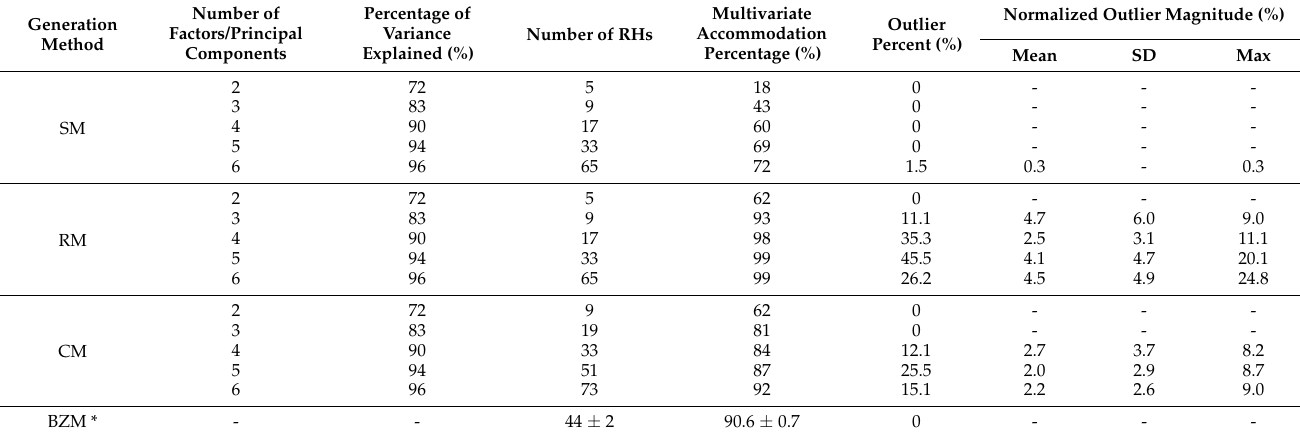
Table 2. Performance comparison of multivariate representative humanoid generation methods (SM, square method; RM, rectangular method; CM, circular method; BZM, boundary zone method). Generation